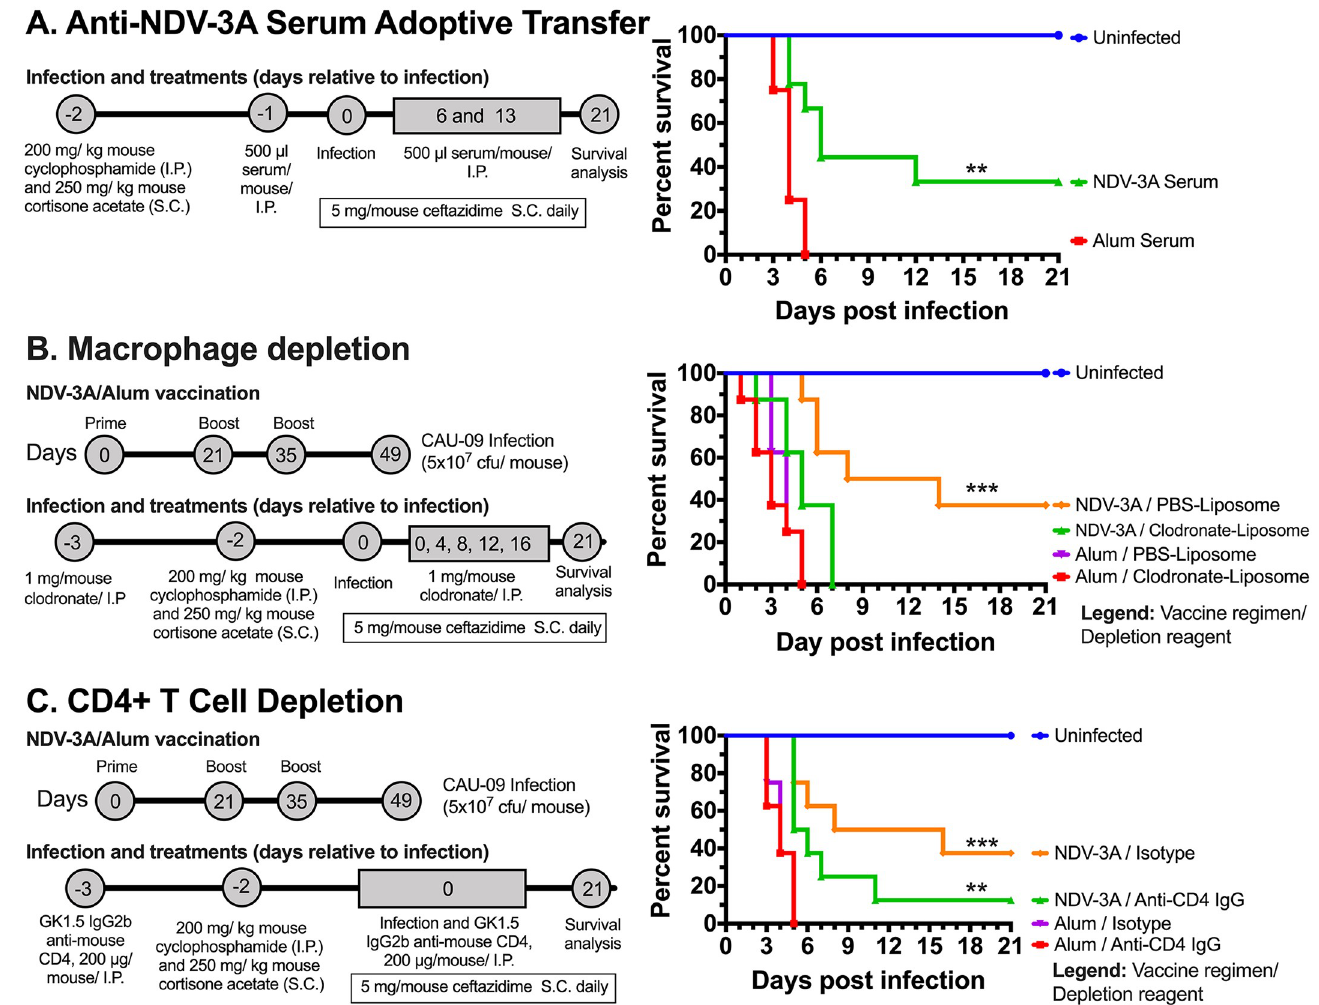
Fig 7. Mechanism of NDV-3A vaccine mediated protection against C . auris infection. (A) Pooled serum from either NDV-3A vaccinated or alum vaccinated mice were administered i.p. weekly to na ï ve neutropenic Balb/c mice (n = 8 per group) starting 24 hours before infection with C . auris . (B) NDV-3A or alum vaccinated Balb/c mice (n = 8 per group) were treated with 1 mg/mouse clodronate-liposome or PBS-liposome (negative control) twice weekly to deplete their macrophages. (C) Anti-CD4 IgG or isotype matching antibodies (200 μ g/mouse) were administered i.p. to NDV-3A or alum vaccinated Balb/c mice (n = 8 per group) on day -3, and 0. In all experiments, mice were made neutropenic on day -2 and infected on day 0 with 5x10 7 cfu/mouse C . auris through i.v. route, and monitored for 21 days for their survival. The mice survival was compared by using Mantel-cox Log-rank Test. The p values < 0.05 was considered